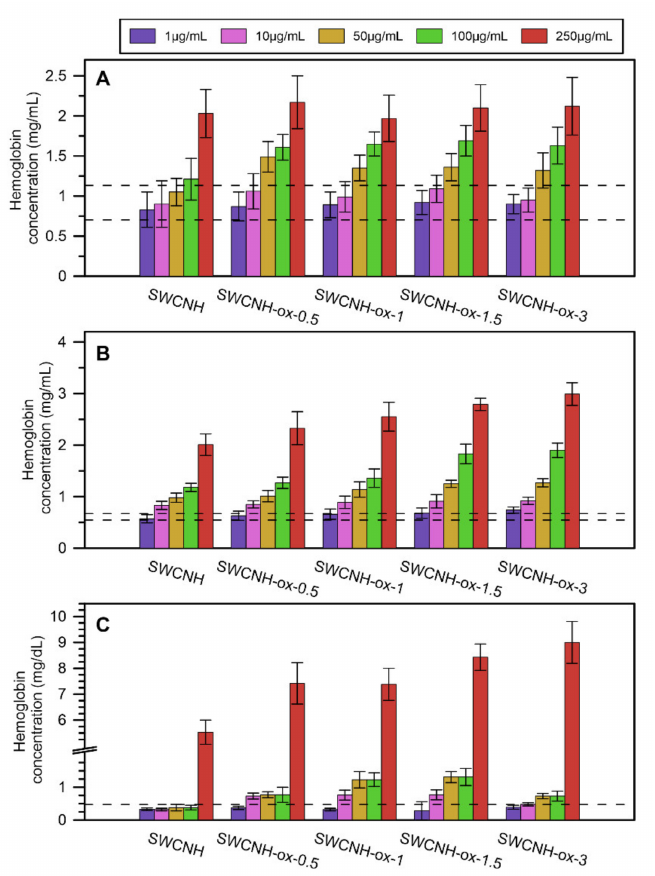
Figure 7. The results of hemolysis investigation by SWCNH-ox materials in different concentrations, 1–250 µ g/mL, on ( A ) human blood, ( B ) porcine blood, and ( C ) erythrocyte suspension obtained from porcine blood. Dotted lines represent the range of data for the